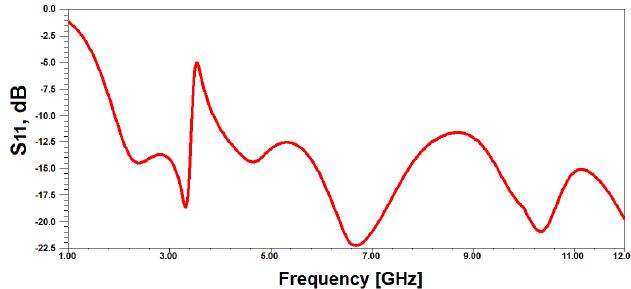
Figure 4: Simulated S 11 of the proposed single band-notch